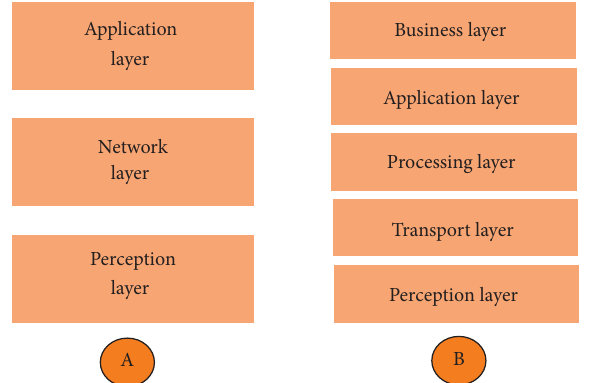
Figure 1: Architecture of IoT (A: three layers) (B: five layers).